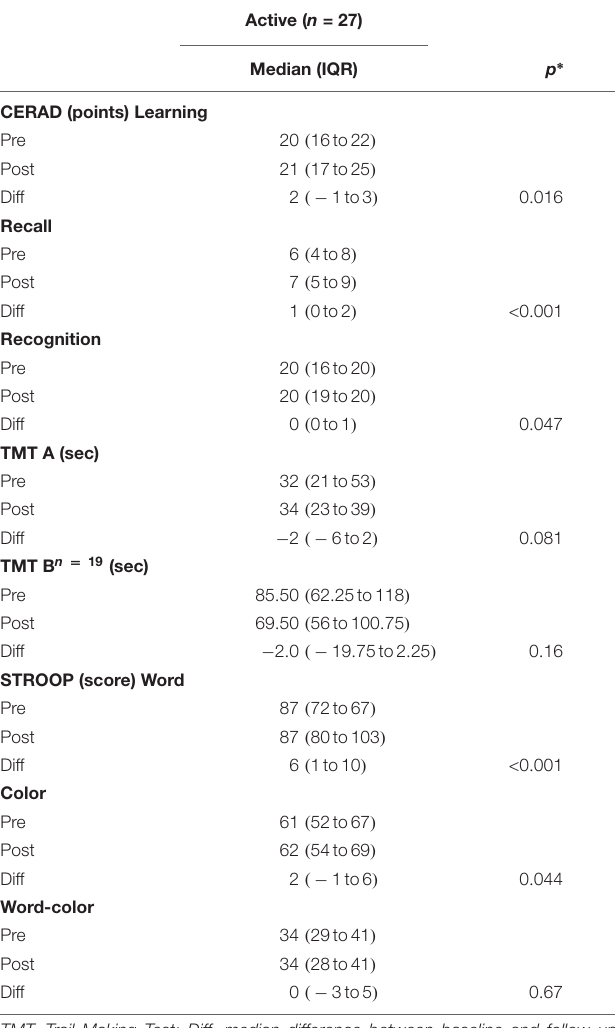
TABLE 4 | Changes from baseline to 16 weeks follow-up in cognitive variables, for participants with supplementation (active). Active ( n =